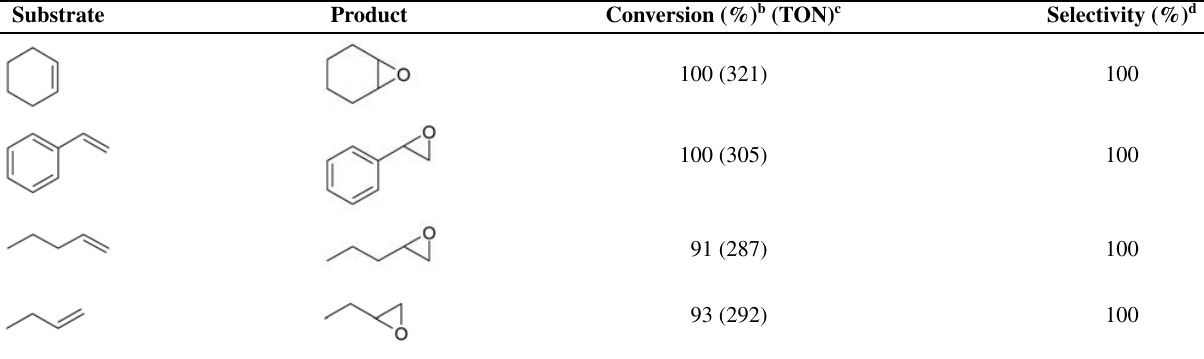
Table 4. The catalytic oxidation results a